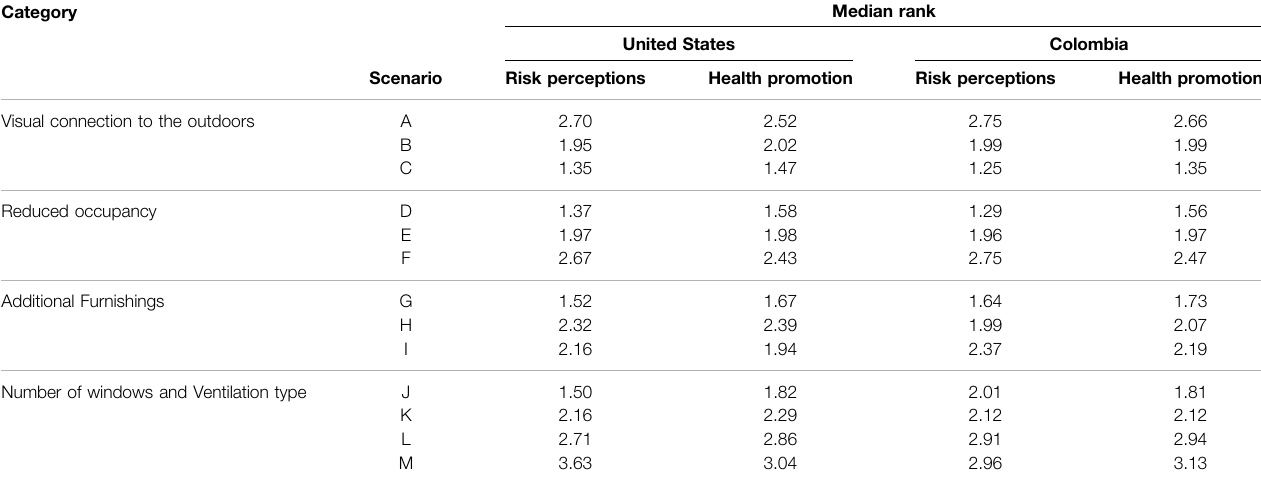
TABLE 1 | Median Ranks of each scenario for health risks and health promotion perceptions in the United States and